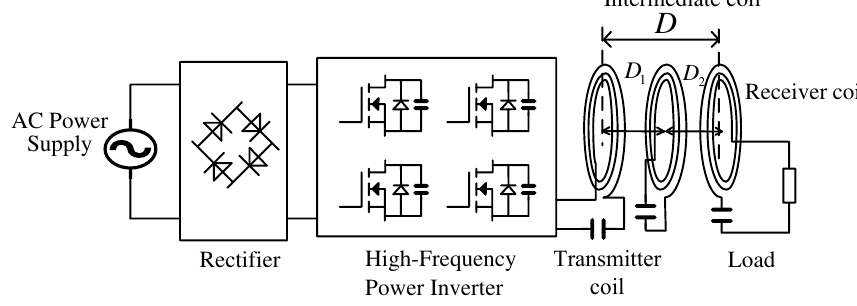
Figure 1. The structure of an MCR-WPT system with a single-intermediate coil.